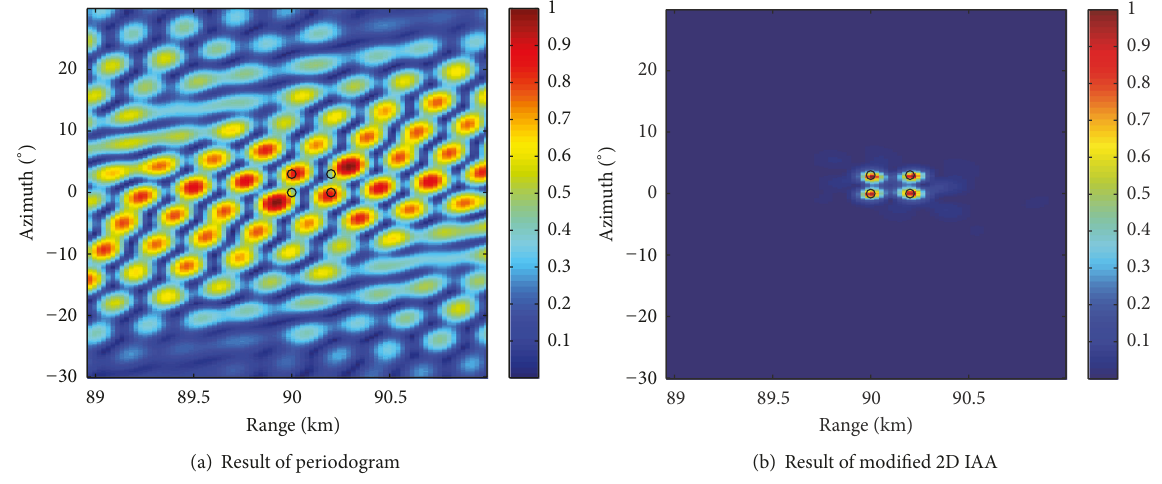
Figure 9: Range-azimuth image formed by periodogram and modified 2D